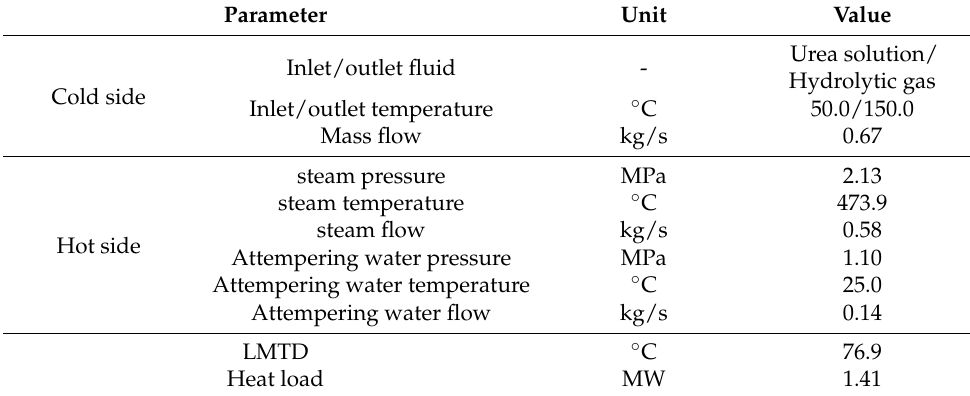
Table 7. Parameters of the UHU of CFPU. Parameter Unit Value Inlet/outlet